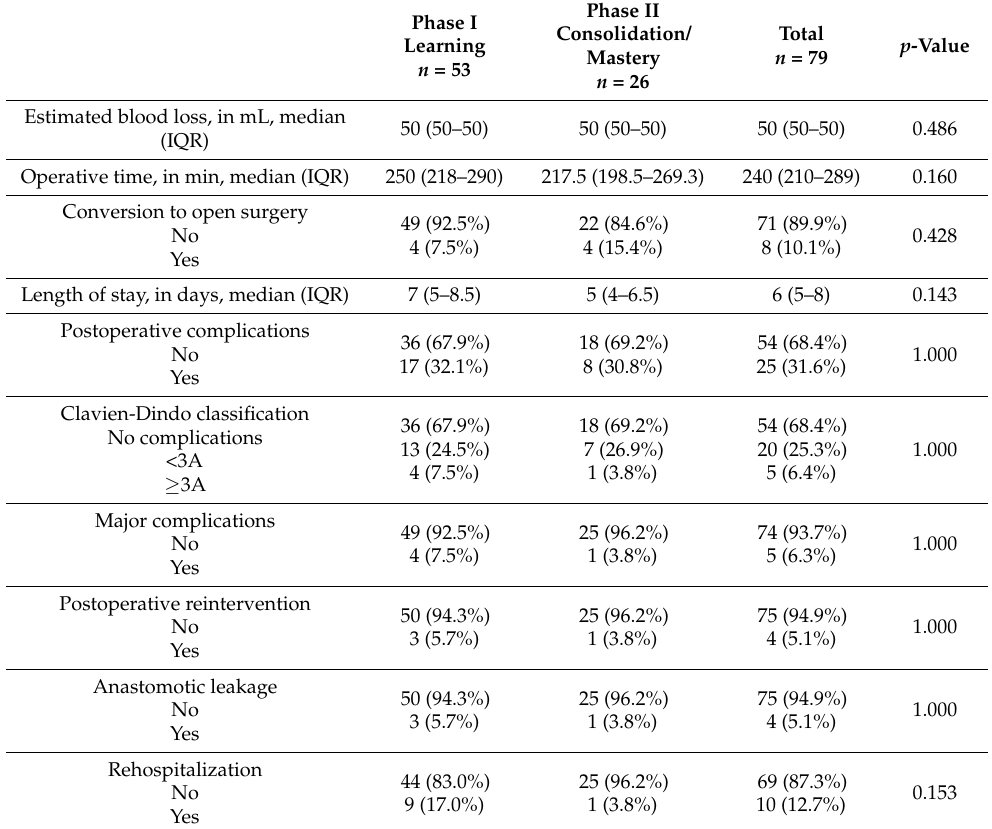
Table 4. Comparison of operative time in different phases of the learning curve for robot-assisted surgery for rectal